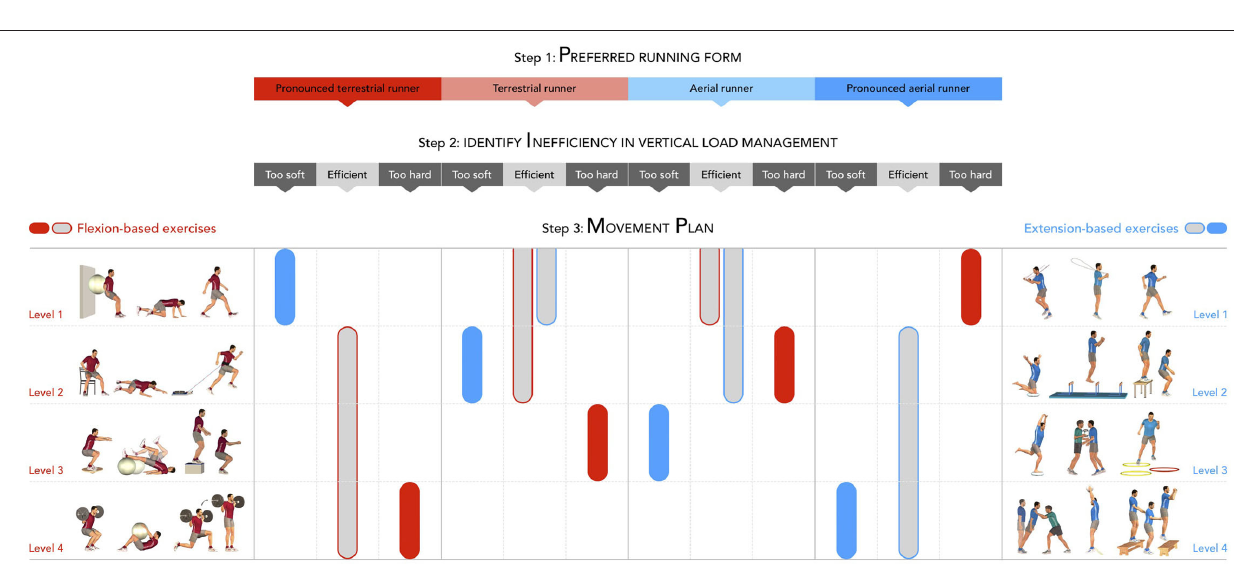
FIGURE 2 | Schematic representation of the three steps (to be read vertically) of the PIMP approach. Exercises are ranked by their degree of flexion (left; red) or extension (right; blue) into four levels, with the fourth level showing the greatest degree of flexion or extension. This ranking allows individualizing the movement plan (step 3) based on the positioning of the runner along the terrestrial-aerial continuum (step 1) and the presence of a possible inefficiency in the vertical load management (step 2). Colored zones indicate if either flexion-based or extension-based are advised and too which degree (level 1–4). Gray areas indicate the proposed exercises for runners with efficient running forms (neither too soft nor too